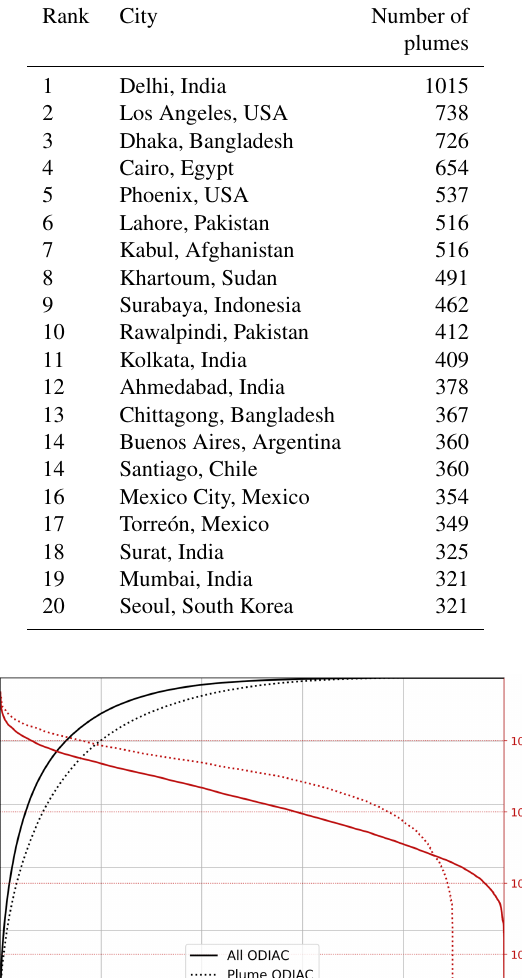
Table 2. Top 20 cities containing the most fossil fuel plumes over the study period.